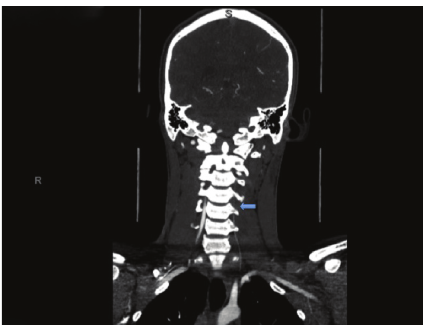
Figure 1: CT Angiogram shows attenuated filling of left vertebral artery (extracranial) almost in its entire length secondary to dissec- tion (marked by solid arrow).